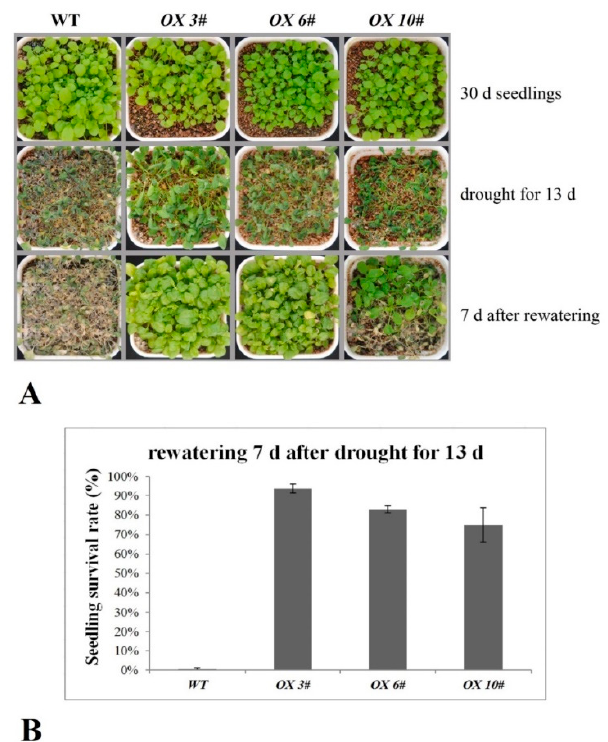
Figure 7. Photographs and survival rates of the CrPIP2;3 OX lines and WT plants grown in soil under normal and drought conditions. ( A ) The effects of withholding water on transgenic lines ( CrPIP2;3 OX 3# , OX 6# , and OX 10# ) and WT; ( B ) the statistics for the survival rate of the transgenic lines and WT A. thaliana after drought stress.